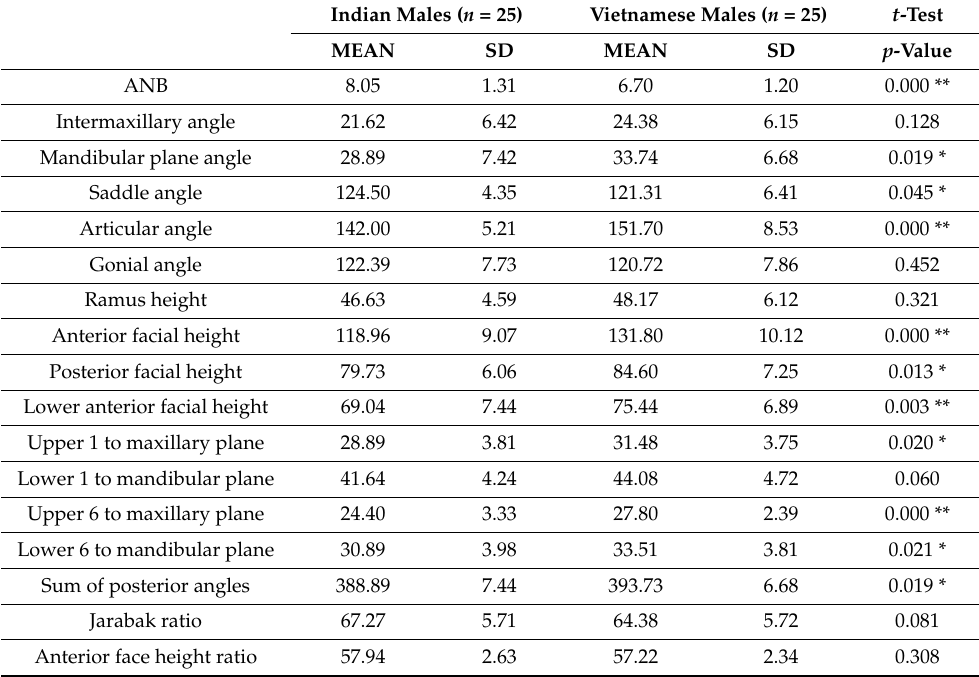
Table 2. Comparison of cephalometric parameters between the South Indian and Vietnamese males. Parameters with statistically significant differences between means ( p < 0.003) are marked with two asterisks, while borderline statistically significant results ( p < 0.05) are marked with one asterisk. Indian Males ( n =